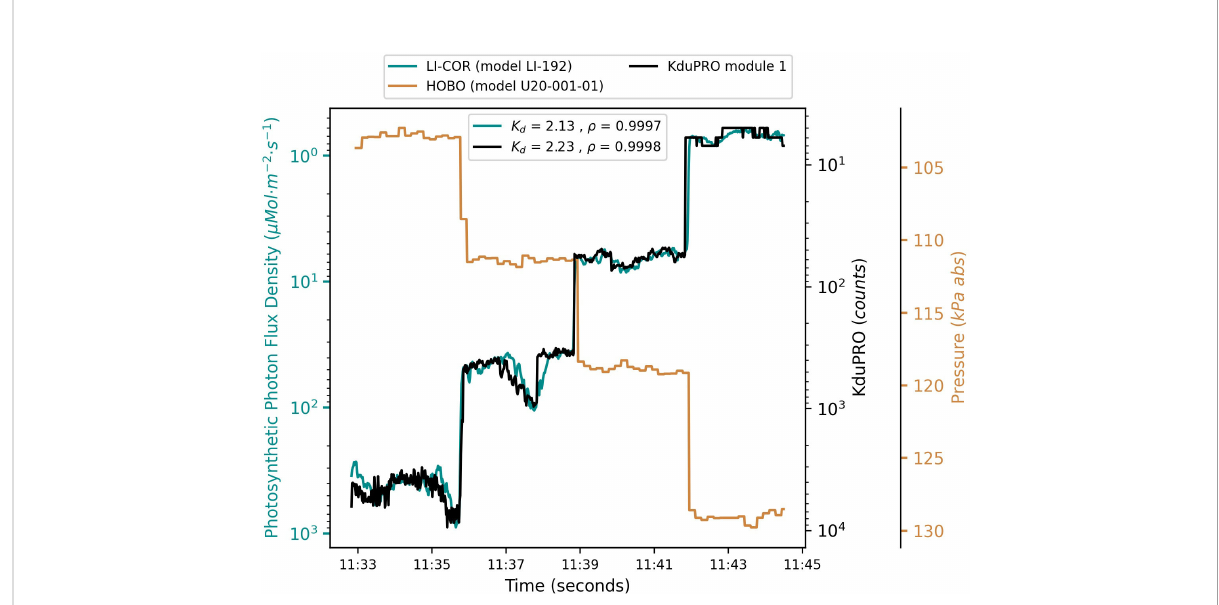
FIGURE 8 Vertical pro fi le measuring the downwelling PAR with one sensor of KduPRO and the LI-COR LI-192 sensor, in logarithmic values. The pressure sensor HOBO U20-001-01 is used to measure the depths